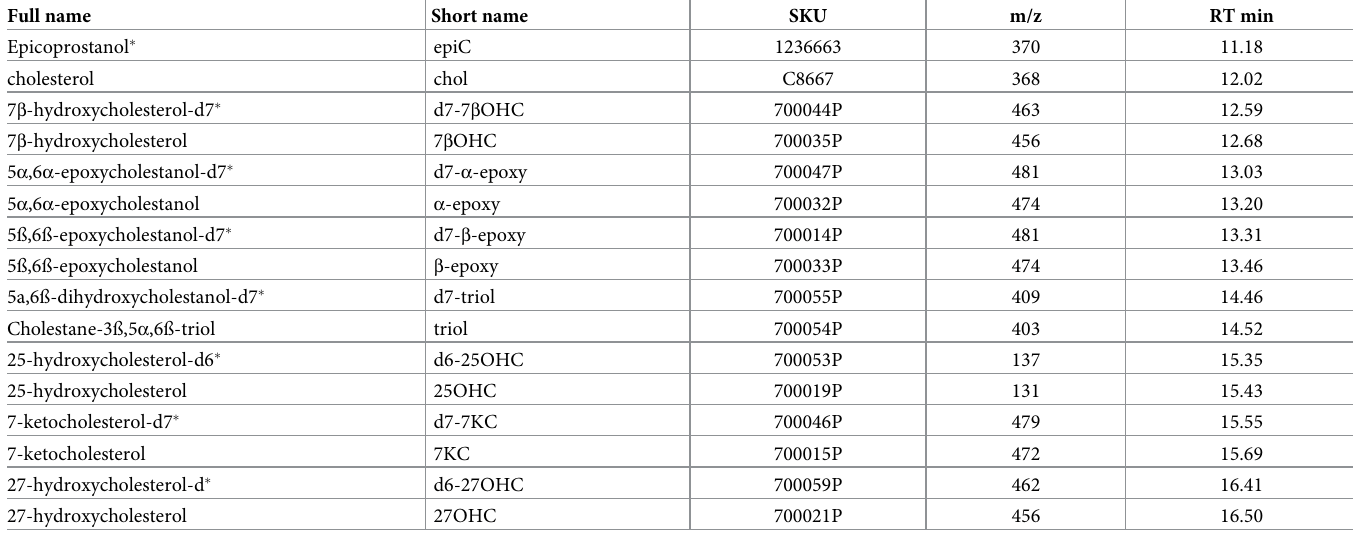
Table 1. List of sterols and oxysterols quantified by isotope dilution mass